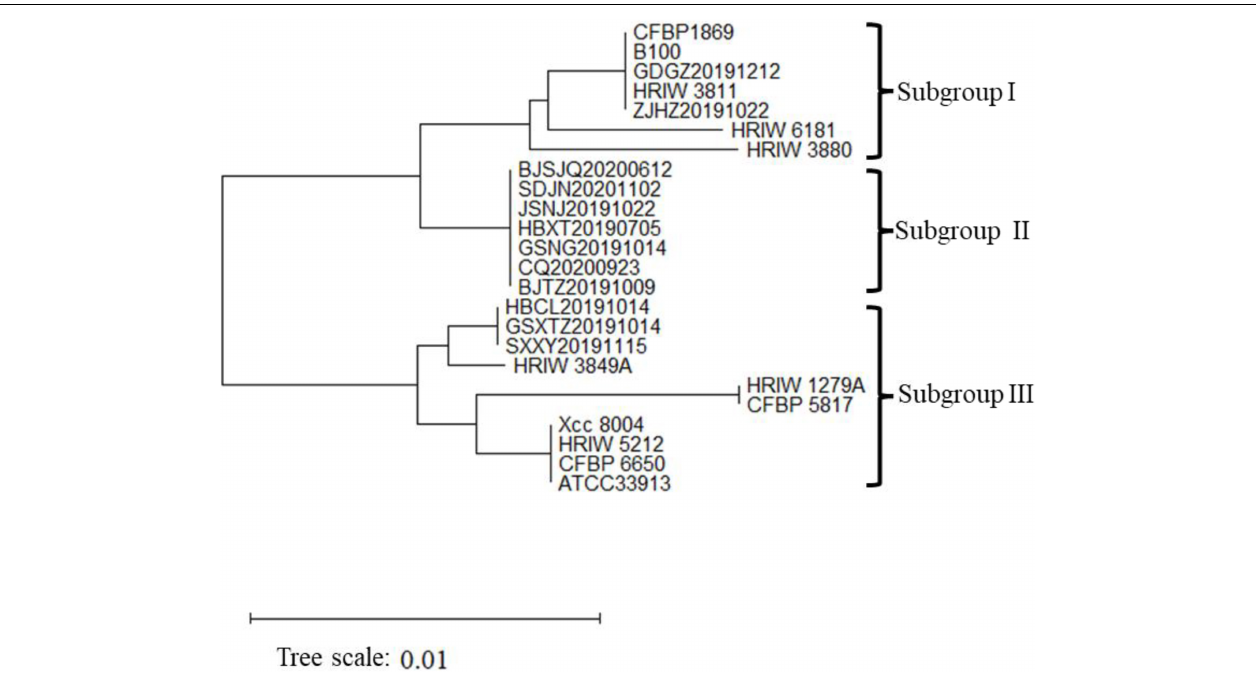
FIGURE 3 | Neighbor-joining tree constructed with concatenated partial sequences of four housekeeping gene ( atpD , gyrB , rpoD , and fyuA ) of our 12 isolated strains and 12 different Xcc race strains. The tree is drawn to scale, with branch lengths in the same units as those of the evolutionary distances used to infer the phylogenetic tree. The tree scale represents